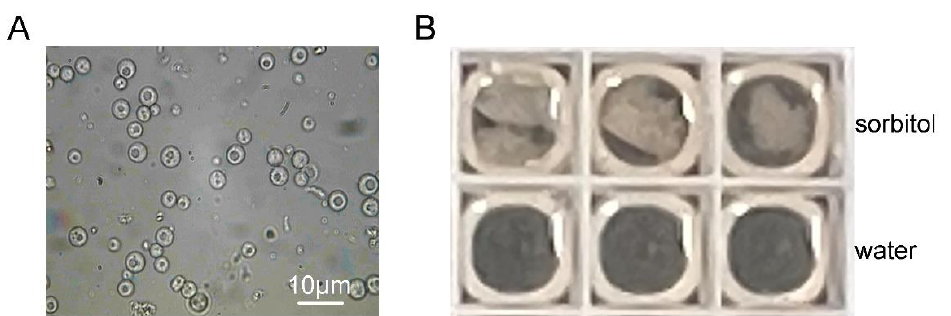
Figure 3. HSAF does not affect protoplast regeneration. ( A ) Protoplasting of N. crassa ; ( B ) Proto- plast regeneration tests with protoplasts suspended in sorbitol or distilled water. 10 6 /mL proto- plasts were inoculated into Vogel ’ s media supplemented with 1 M sorbitol and 30 µM HSAF .